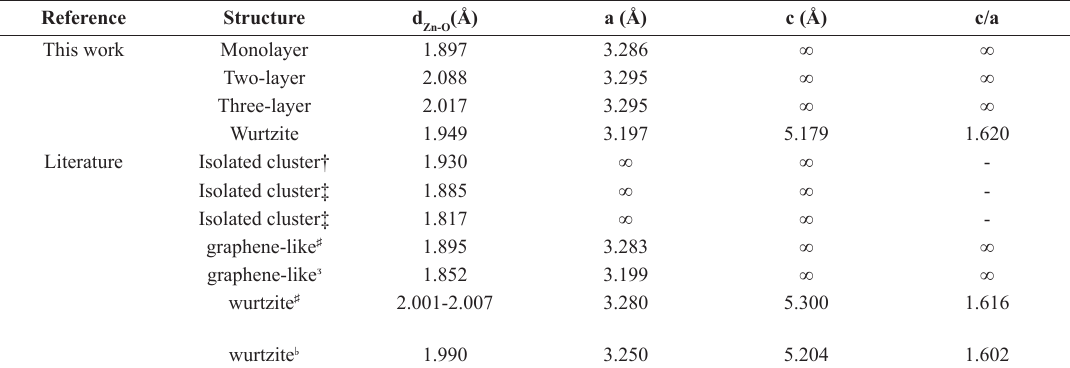
Table 1: Crystal lattice parameters and structure found in this work and theoretical and experimental values for wurtzite and graphene-like structures in literature. Reference